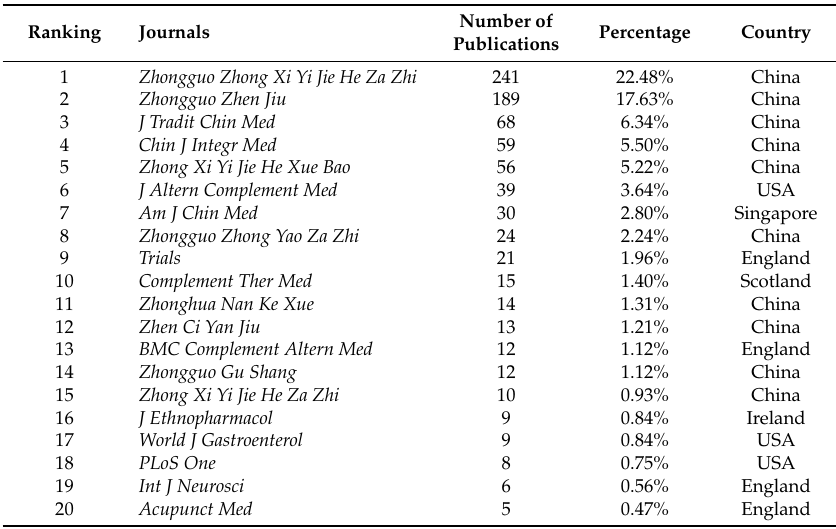
Table 2. Ranking of journals with TCM publications by